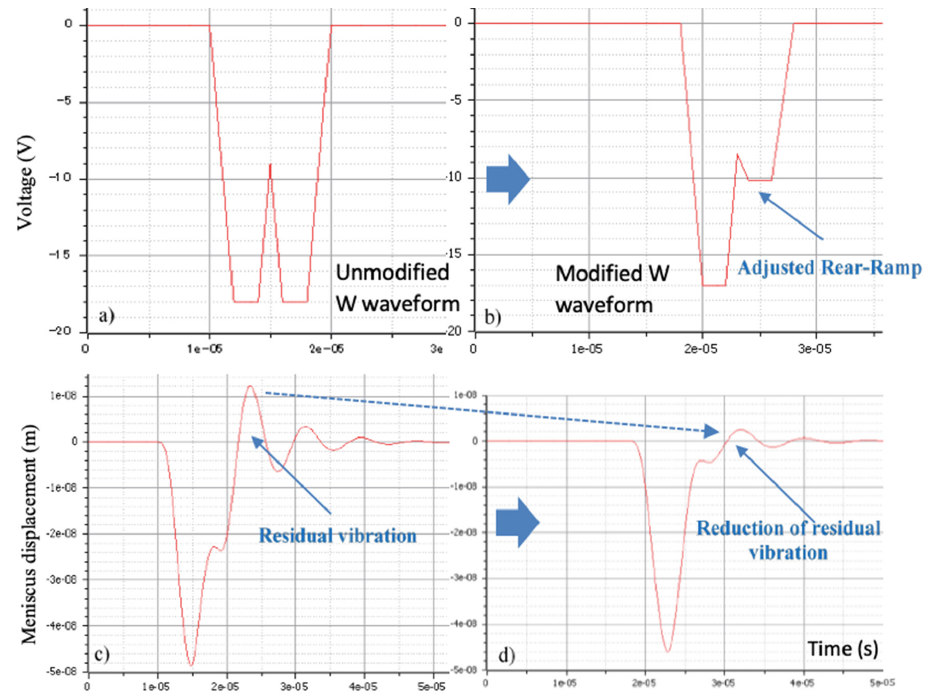
Figure 7. Comparison of and modified W waveform. ( a ) Input of unmodified W waveform, ( b ) in- put of modified W waveform with adjusted rear ramp, ( c ) response of unmodified W waveform, ( d ) response of modified W waveform with adjusted rear ramp.